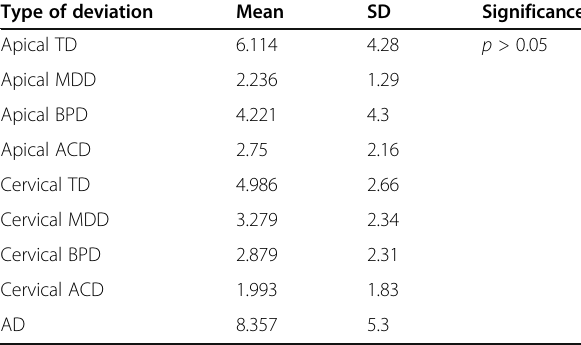
Table 2 Mean values of different deviations Type of deviation